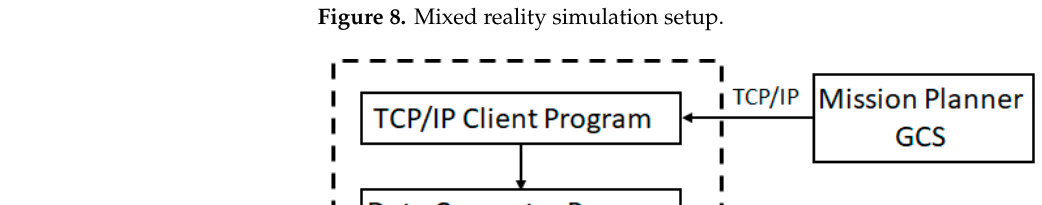
Figure 8. Mixed reality simulation setup.